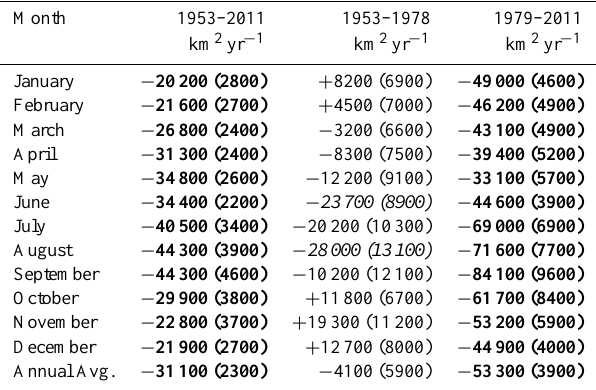
Table 4. Monthly trends for different time periods of the combined time series. Trends are in km 2 per year (with trend standard devia- tion in parentheses). Trend values in bold are statistically significant at the 99% level; values in italics are significant at the 95% level.